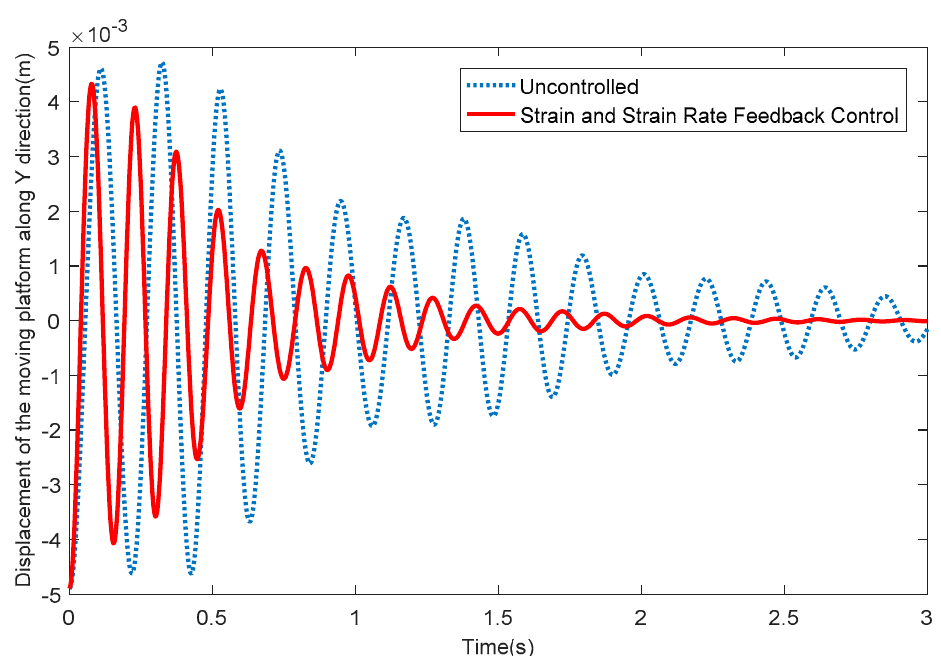
Figure 10. Elastic displacements of the moving platform along the Y direction.